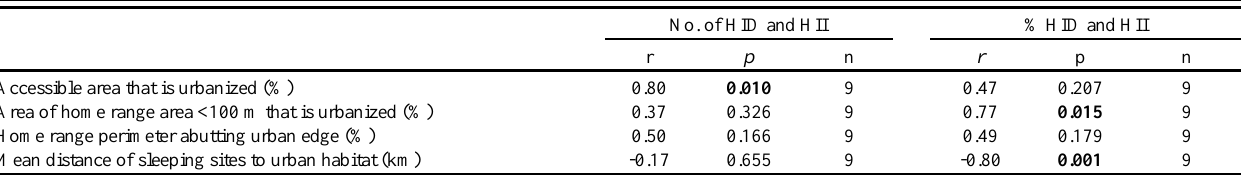
Table 3 . Results of Pearson correlations testing for significant relationships between spatial variables and total number of human- induced deaths (HID) and human-induced injuries (HII) per troop, and between spatial variables and mean annual percentage of HID and HII per troop. Bold values indicate significant differences at p £ 0.05. No. of HID and HII % HID and HII r p n r p n Accessible area that is urbanized (%)